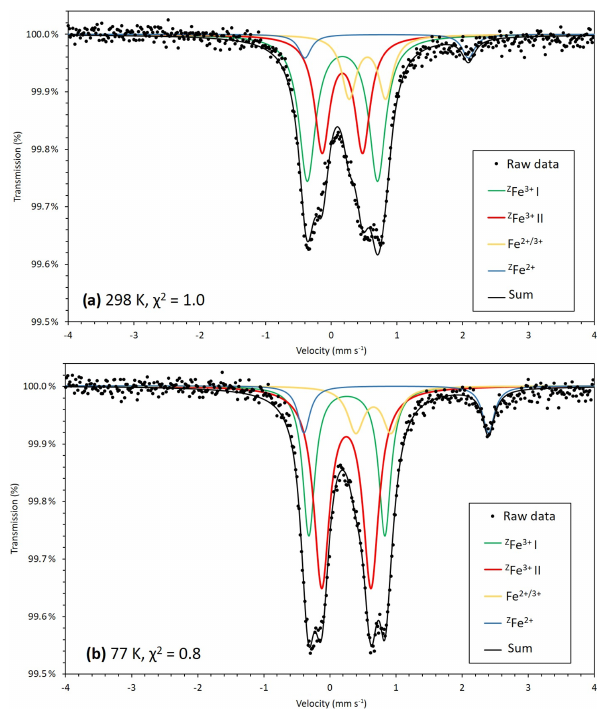
Figure 5. Transmission 57 Fe Mössbauer spectrum of monteneveite measured at 298K, χ 2 = 1 . 0 (a) and 77K, χ 2 = 0 . 8 (b) . Both green and red lines correspond to [ 4 ] Fe 3 + while [ 4 ] Fe 2 + is represented by the blue line. The yellow line cannot directly be attributed to either octahedrally coordinated Fe 3 + or Fe 2 + and may represent a delocalized electronic state, which could explain why the 77K spectrum is better resolved.